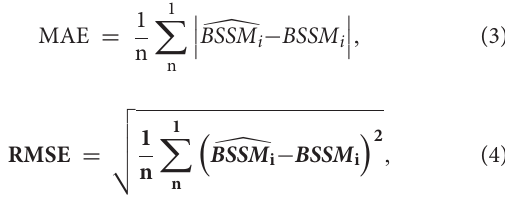
metrics to assess the performances of GRNN algorithms for soil moisture retrieval in terms of prediction accuracy. These